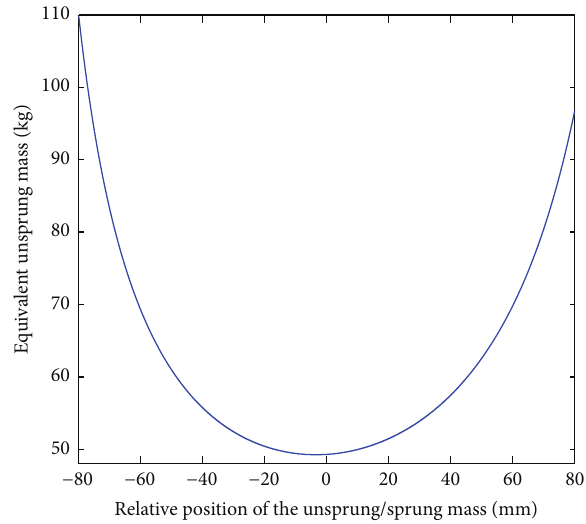
Figure 5: Equivalent unsprung mass versus different relative posi- tion of the unsprung